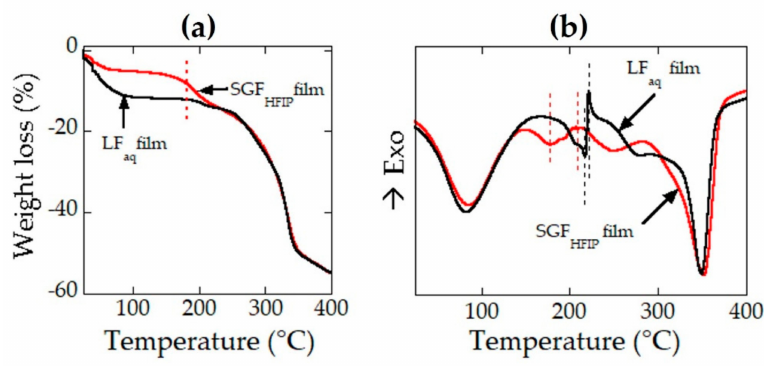
Figure 5. Thermal gravimetry (TG) ( a ) and di ff erential scanning calorimetry (DSC) ( b ) profiles of S. c. ricini LF aq (profile in black) and SGF HFIP (profile in red) as-cast